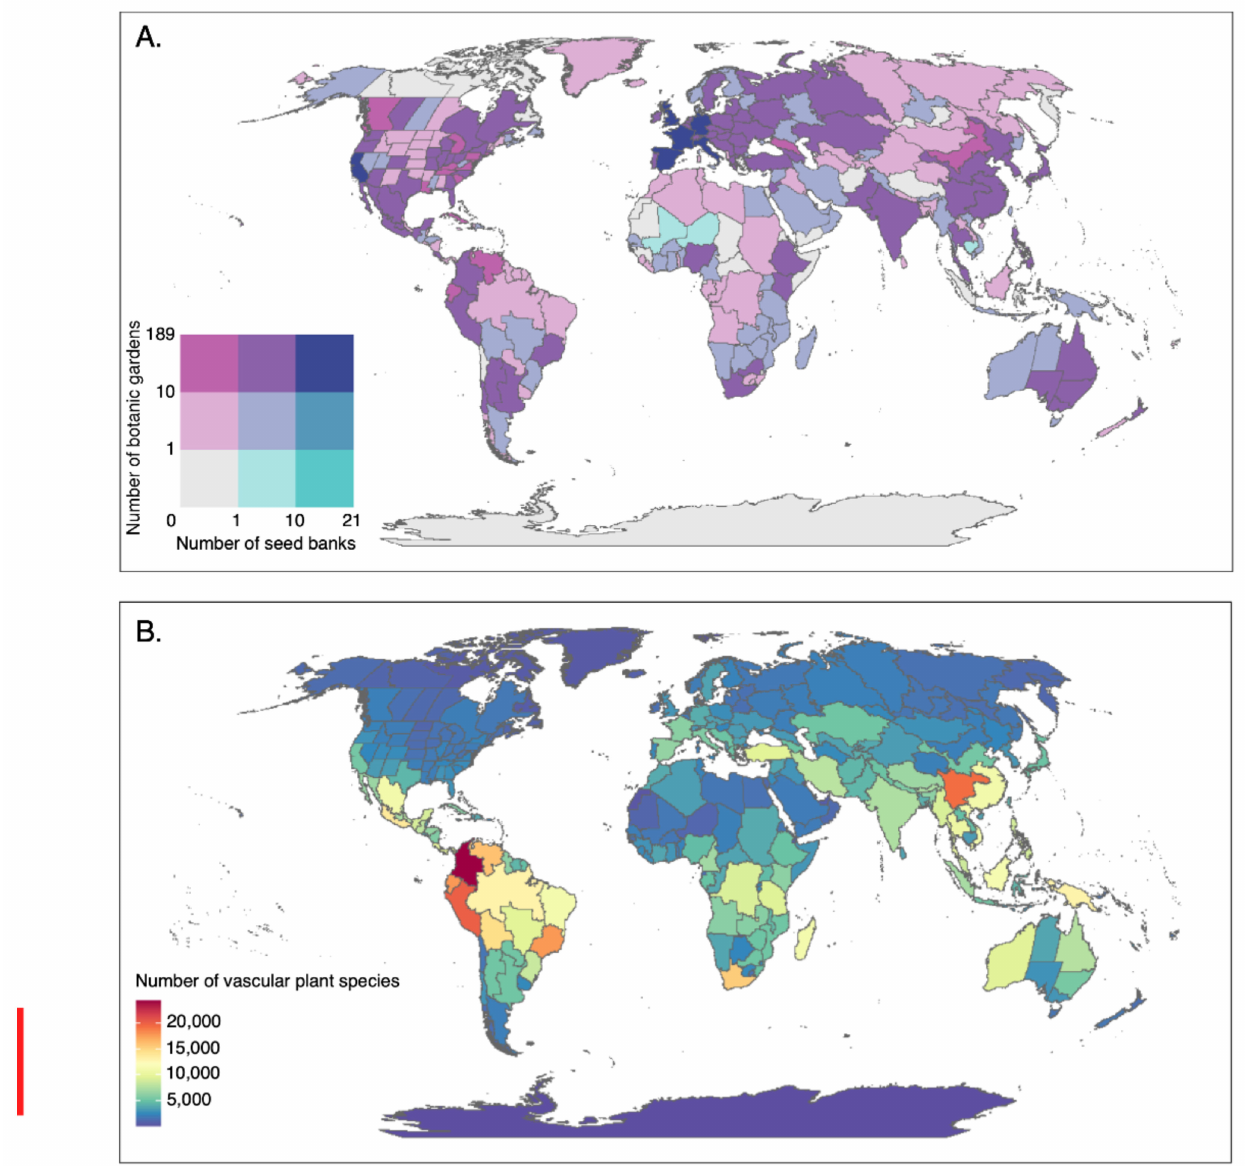
Figure 3. Geographic distribution of ( A ) ex situ conservation capacity and ( B ) centres of plant species richness. Ex situ conservation capacity is represented by the numbers of seed banks and botanic gardens found in each botanical region of the world according to level 3 of the World Geographical Scheme for Recording Plant Distributions (WGSRPD) [69]. Numbers of seed banks per region were extracted from the Millennium Seed Bank Partnership (MSBP) and Botanic Gardens Conservation International (BGCI), whereas numbers of botanic gardens per region were extracted from only the latter. For direct comparison, plant species richness was also extracted for each botanical region (level 3 WGSRPD) from the World Checklist of Vascular Plants